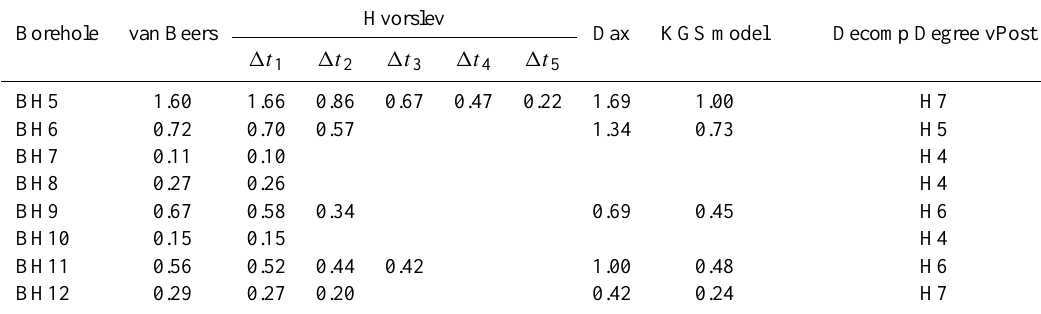
Table 1. Horizontal hydraulic conductivity K h (md − 1 ) computed from the slug tests.